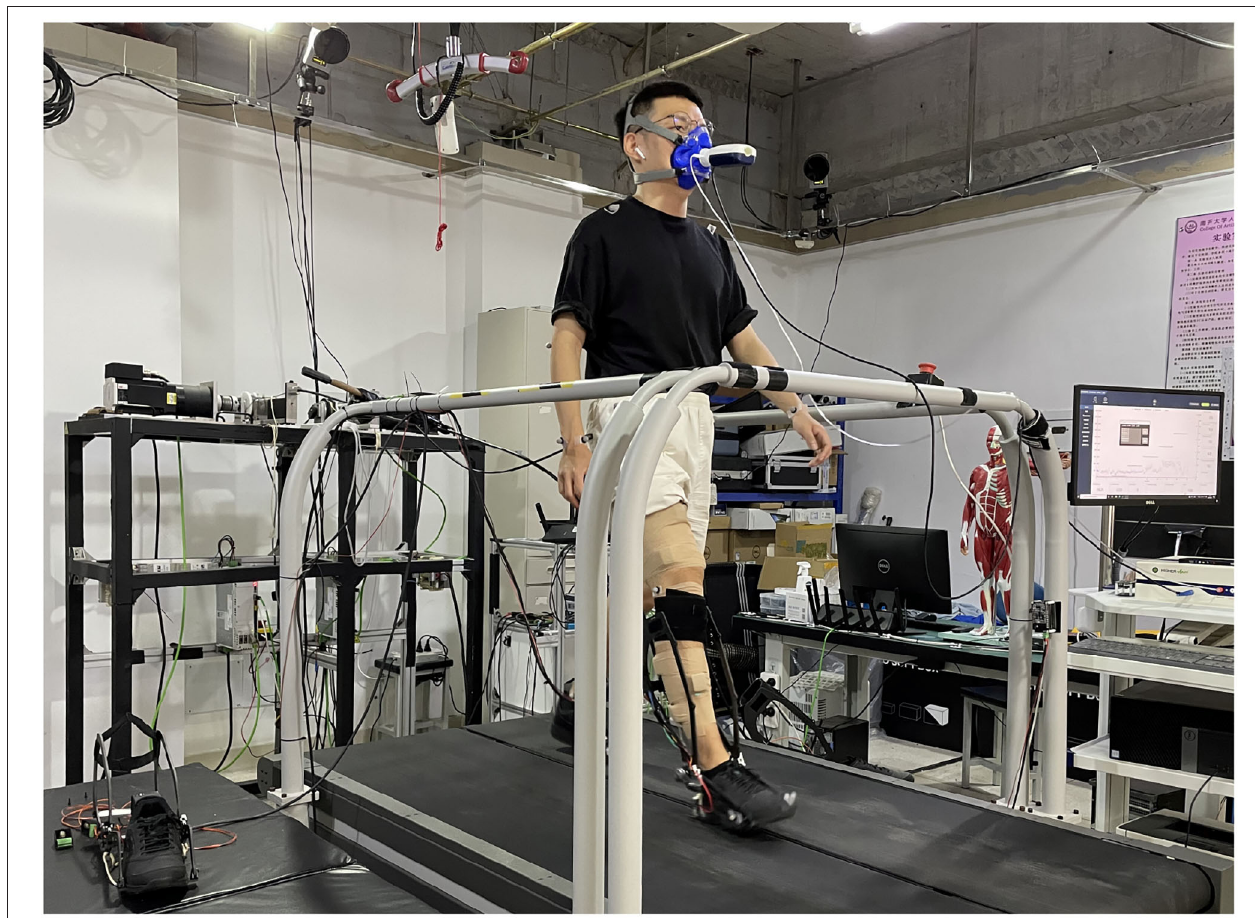
FIGURE 5 | Photograph of human walking with an ankle